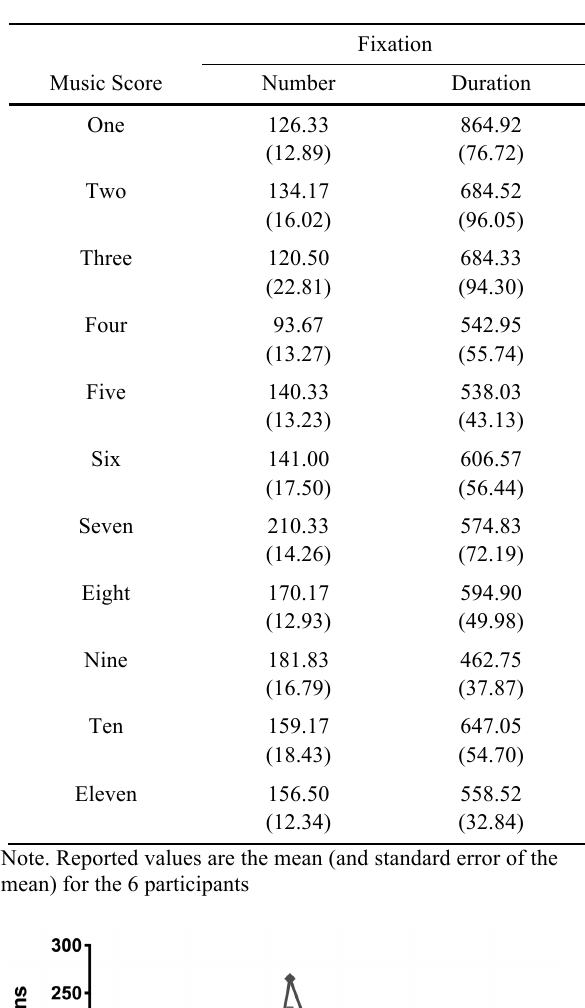
Table 3. The number of mean fixation and fixation duration for each music score.